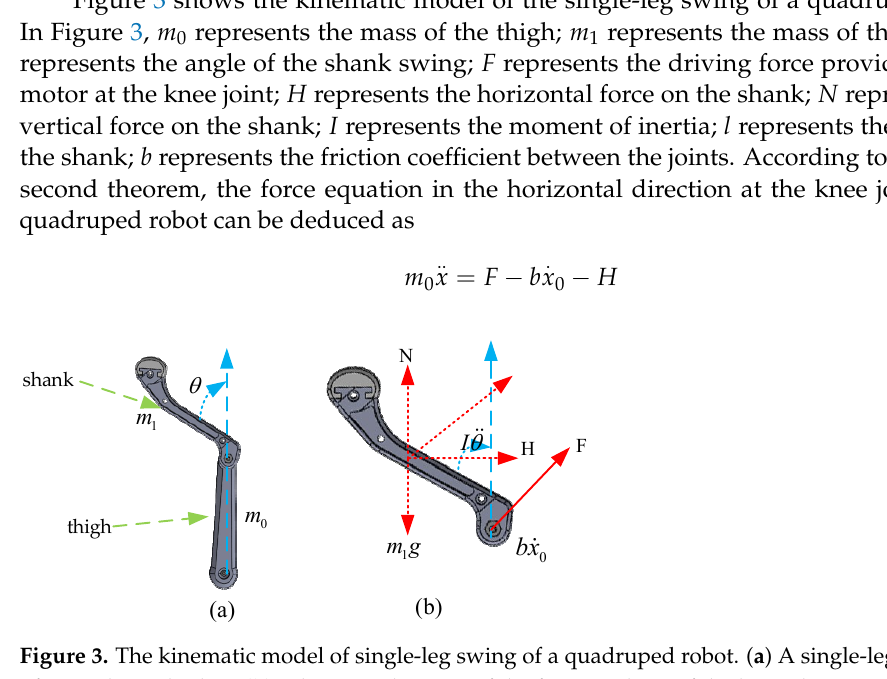
Figure 4. The coordinate system of the quadruped robot. ( a ) The initial state of contact between the shell and the ground after the robot is overturned. ( b ) The solid line indicates the positional state of the robot after the rotation, and the dashed line indicates the positional state of the robot in the initial state. ( c ) The positional state of the robot after the rotation. In order to restore the robot to its normal state, the robot ʹ s shell will be rotated around its circle center by an angle 𝜑 , and the state of the robot after the rotation is shown in Figure 4b. Since the robot ʹ s shell is an arc ‐ shaped structure, point A is always the contact